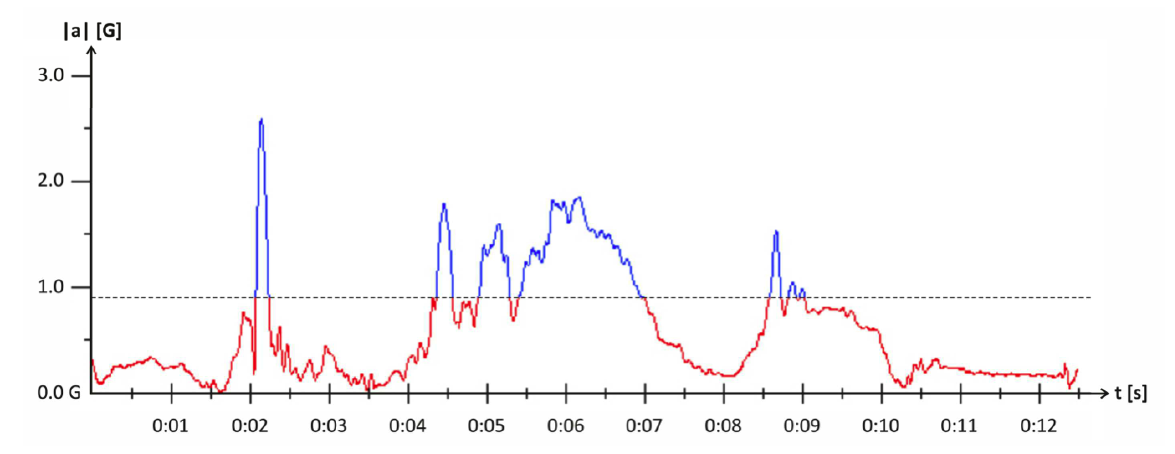
Figure 4. Thresholds for level 2